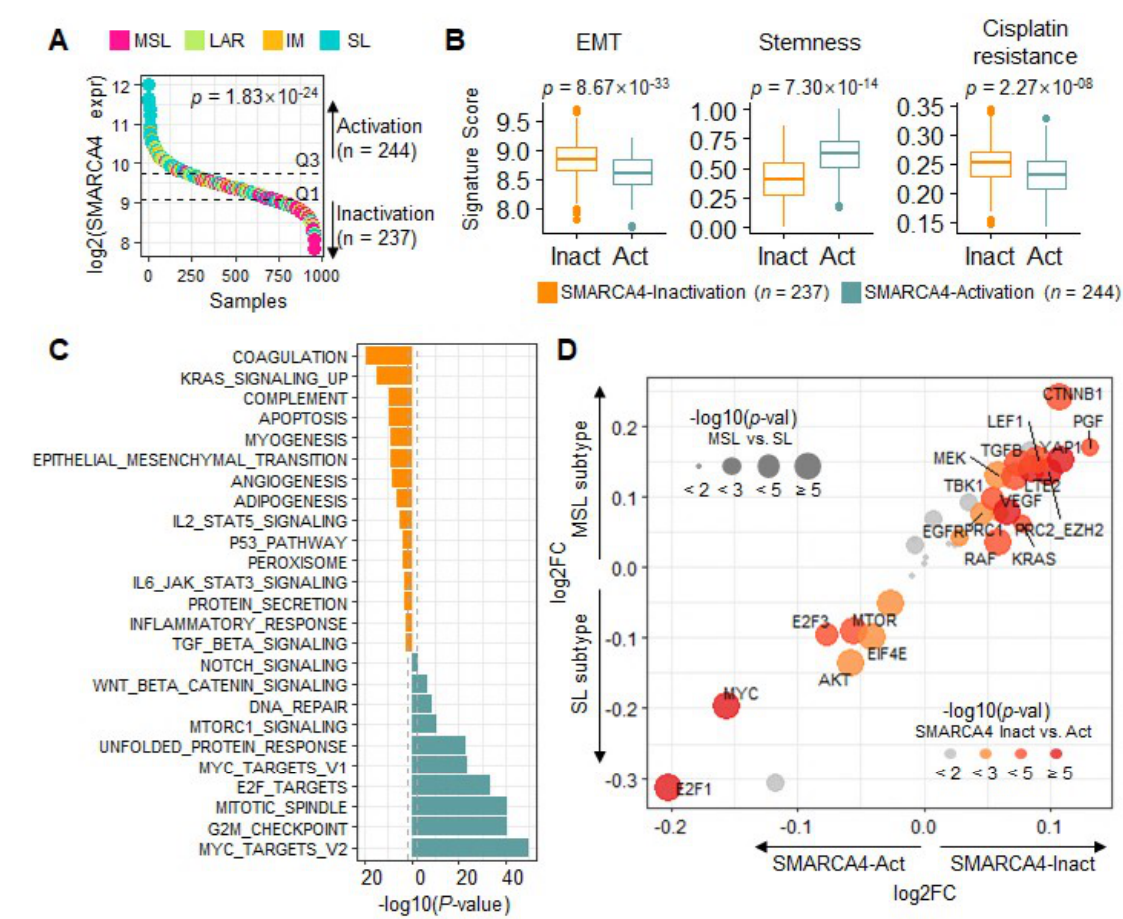
Figure 2. Global gene regulation according to SMARCA4 activation status. ( A ) A waterfall plot of sorted SMARCA4 gene expressions of TNBC samples ( n = 957). Y-axis indicates log2-scale SMARCA4 mRNA expression. Each sample is colored according to TNBC subtype (MSL: pink; LAR: light green; IM: orange; SL: light blue). The p -value denotes the enrichment of subtypes by SMARCA4 activation group as determined by chi-square analysis. ( B ) Boxplots of gene signature activity scores in the SMARCA4 inactivation (orange) and activation (teal) groups. Two groups were classified by upper and lower tertile of SMARCA4 gene expression. The EMT and stemness scores are indicative of the MSL and SL subtypes, respectively, and the cisplatin resistance score is also shown. p -values were calculated by t -tests. ( C ) Bar plot of log-scale p -values for GSVA limma test for the SMARCA4 inactivation (orange) and activation (teal) groups. ( D ) Scatter plot of the oncogene signature scores. The X- and Y-axes indicate the log2FC in the average scores between the SMARCA4 activation and inactivation groups and between the MSL and SL groups, respectively. Circle size indicates the rescaled p -value for the GSVA of oncogene signatures between subtypes (MSL vs. SL), and circle color indicates the rescaled p -value according to SMARCA4 group (inactivation vs.